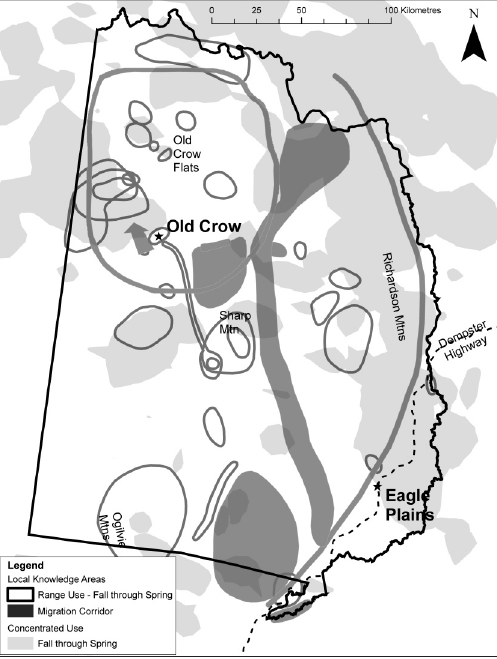
Fig. 4. Overlay of concentrated use areas and habitat suitability map for the winter season. Concentrated use areas (thick black outline), high quality habi- tat (black shading), moderate quality habitat (light grey shading), and lowest to low quality habitat (no shading) are